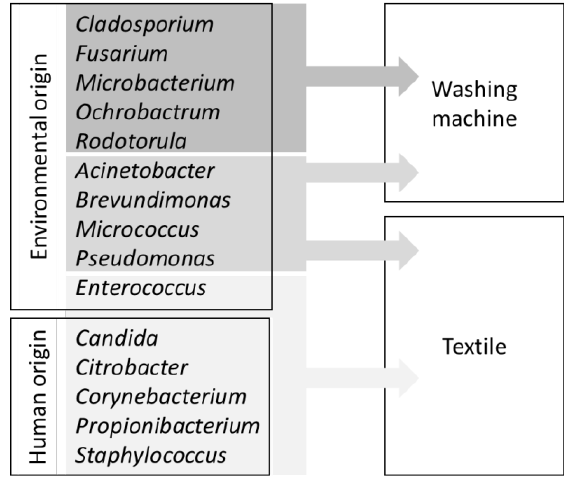
FIGURE 1: Selected microorganisms found on textiles or in washing machines and their possible origins (adapted from